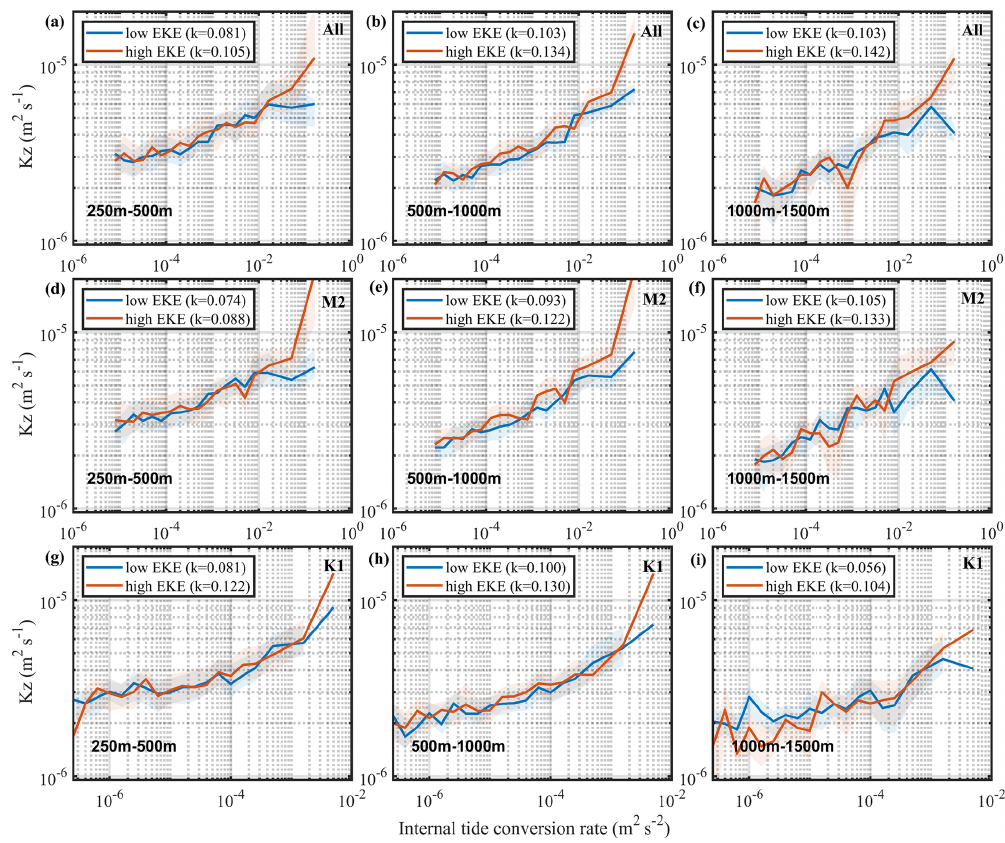
Figure 9. The averaged diffusivity between depths of (a, d, g) 250–500m, (b, e, h) 500–1000m, and (c, f, i) 1000–1500m in high (greater than the median) and low (less than the median) EKE. The shading indicates 1 standard deviation. Panels (a, b, c) , (d, e, f) , and (g, h, i) are related to the eight main tidal constituents, M 2 internal tide, and K 1 internal tide,